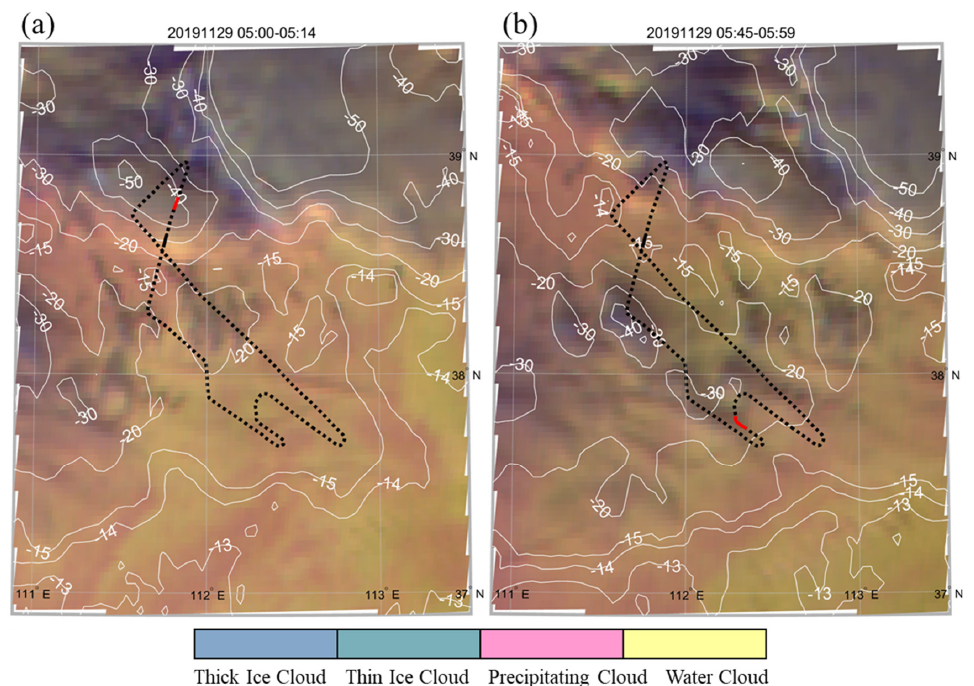
Figure 11. Multispectral composite images of FY-4A satellite at 05:00–05:14 UTC ( a ) and at 05:45– 05:59 UTC ( b ) on 29 November 2019; the others are the same as Figure 9.